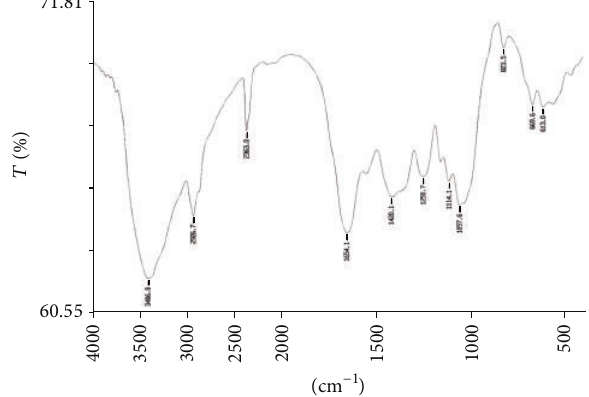
Figure 7: FTIR spectra of +NO 3 (DDN) treated biomass showing different functional groups. The “ 𝑥 ” axis of the spectra denotes wavenumber (cm −1 ) and “ 𝑦 ” axis denotes transmittance (% 𝑇 ).